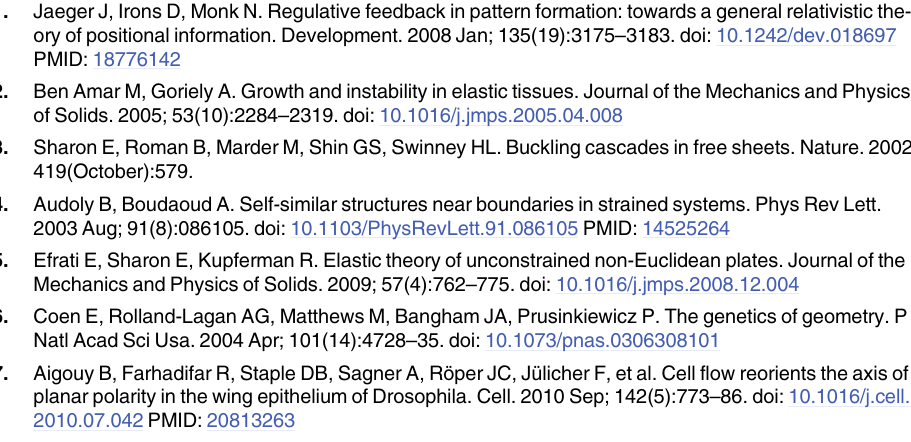
S5 Fig. Relevance to young, differentiating leaves. Veins are marked by the early provascular reporter pVH1::GUS . We classify leaves according to whether they have tertiary veins (older leaves, e.g. L3) or not (younger leaves, e.g. L1 and L2). The shape of the midvein in younger leaves is smooth and straight (59 out of 62 leaves) while for older leaves, it is generally kinked at junctions with secondary veins (37 out of 51 leaves). Examples of kinked and unkinked junc- tions are marked with red and green arrows, respectively. All leaves are at the same scale, L1